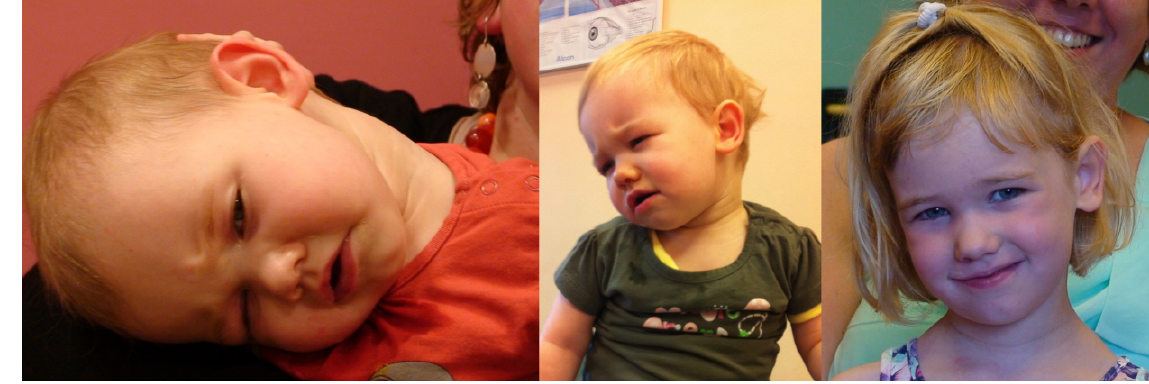
Figure 1: Torticollis before, 6 months after and 42 months after resection